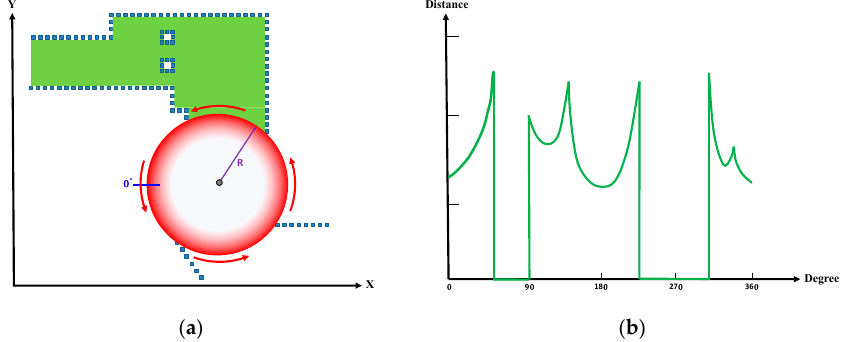
Figure 5. Extraction of the environmental features. ( a ) Virtual LiDAR scan. ( b ) Environmental features scanned within the radius R.